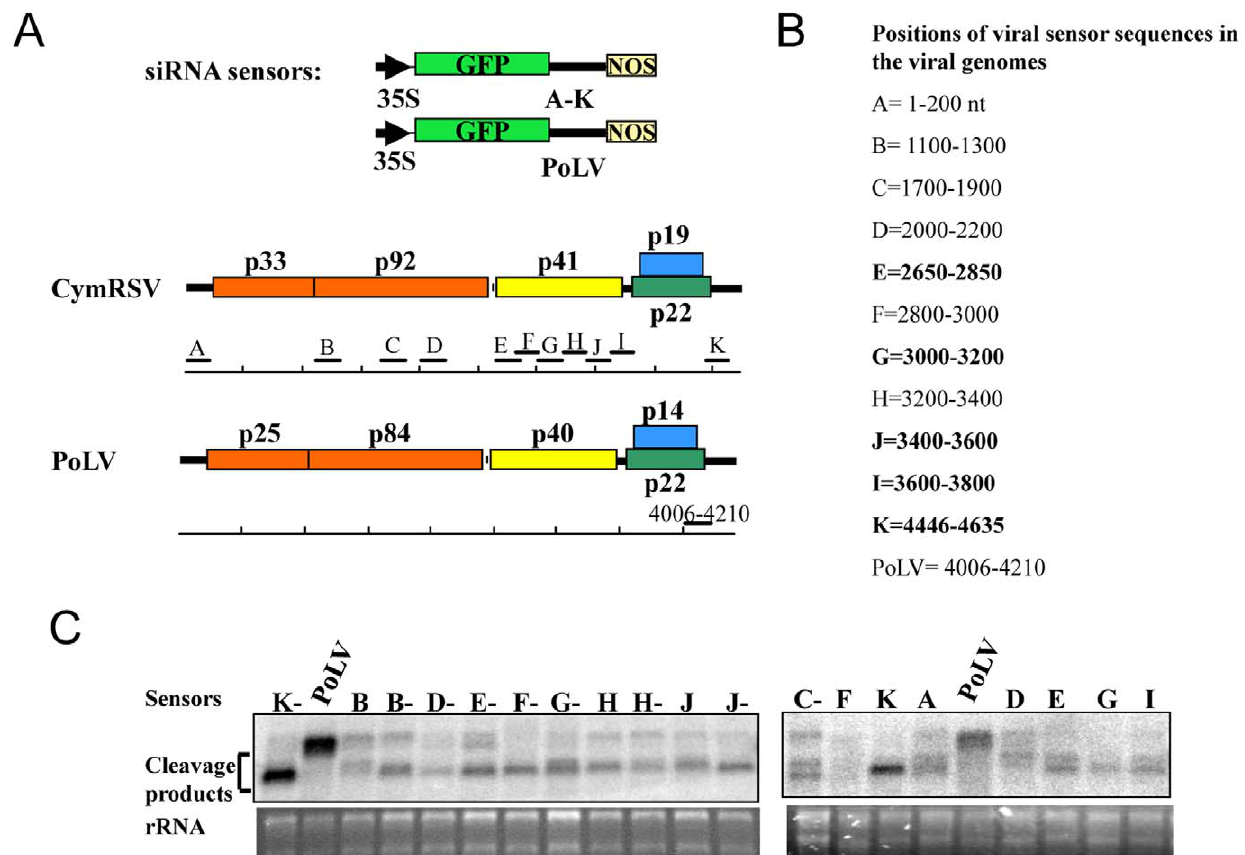
Figure 5. Functional analysis of vsiRNAs inplanta . A: Schematic illustration of the GFP sensor sequences and their origins in the viral genomes. The GFP and viral coding sequences are indicated by coloured open boxes, and non coding regions are indicated by thick black lines. Viral target sequences, CymRSV: A to K and Photos Latent Virus (PoLV) [24] as a control, inserted downstream to the GFP ORF are scaled and positioned along the viral genomes. B: Length and position of viral sensor sequences are listed, and regions that contain hotspots are shown in bold. C: Northern blot analysis of viral sensor mRNAs agroinfiltrated into Cym19stop-infected N. benthamiana plants. RNA extracts at 3 days after agroinfiltration were analysed with a 32 P-labeled RNA probe raised against the 3 9 -terminal part of the GFP ORF. PoLV indicates the negative uncleaved control, while the CymRSV viral sequences are indicated by the capital letters. The letter followed by ‘‘-’’ indicates the negative orientation of the sensor sequence, rRNA was used as loading control.